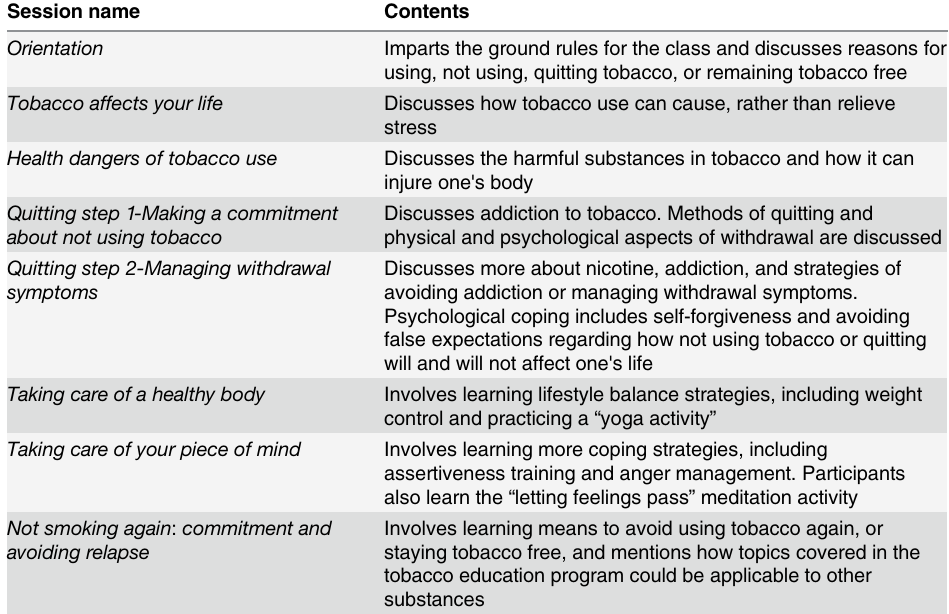
Table 1. Project EX